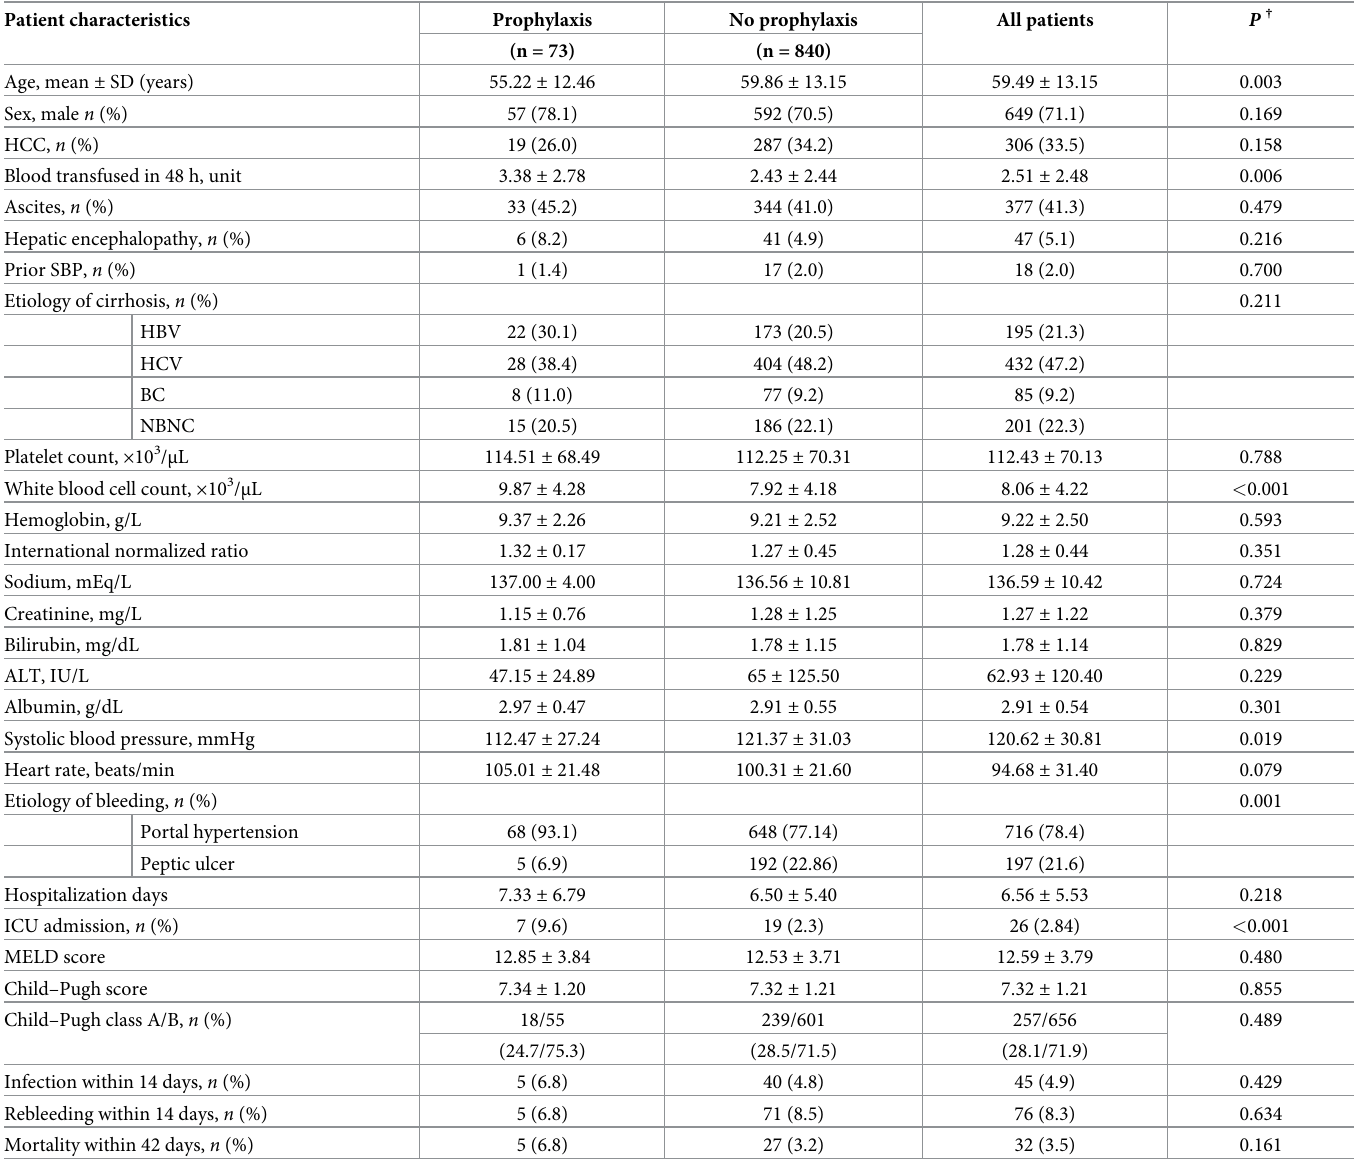
Table 1. Baseline patient